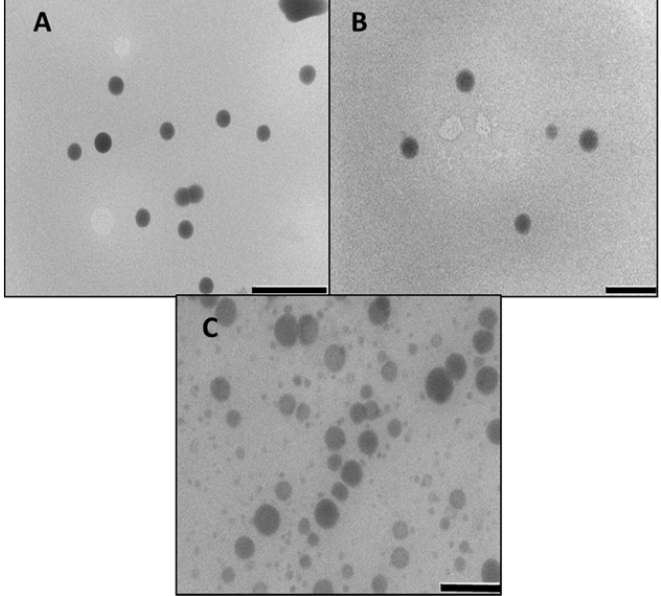
Figure 1. TEM images of ( A ) Selenium nanoparticles (SeNPs), ( B ) SeCh, and ( C ) SeChFA. Bar = 200 nm.